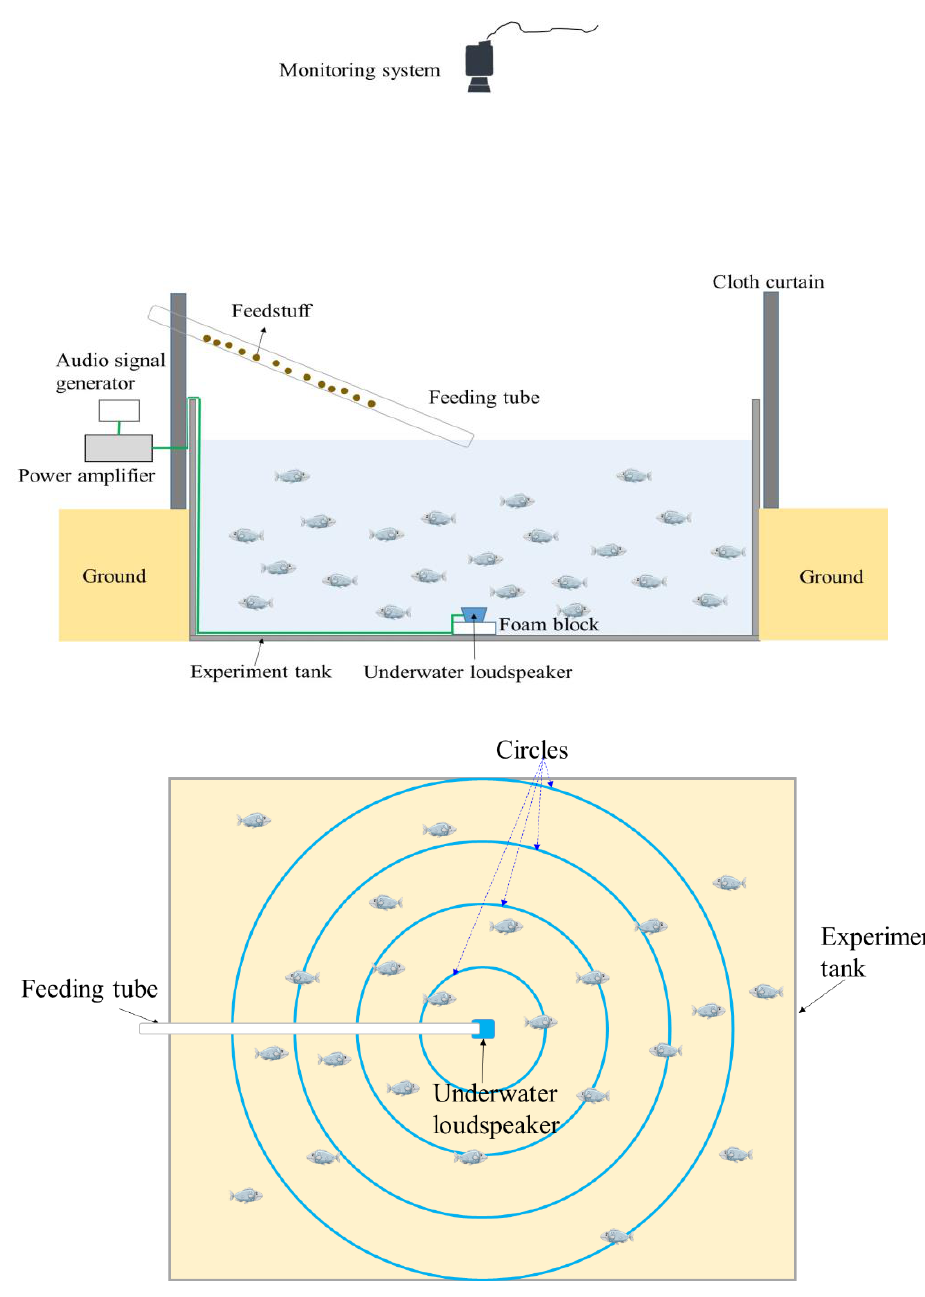
Figure 3. Sketch of the experimental acoustic conditioning taming tank.